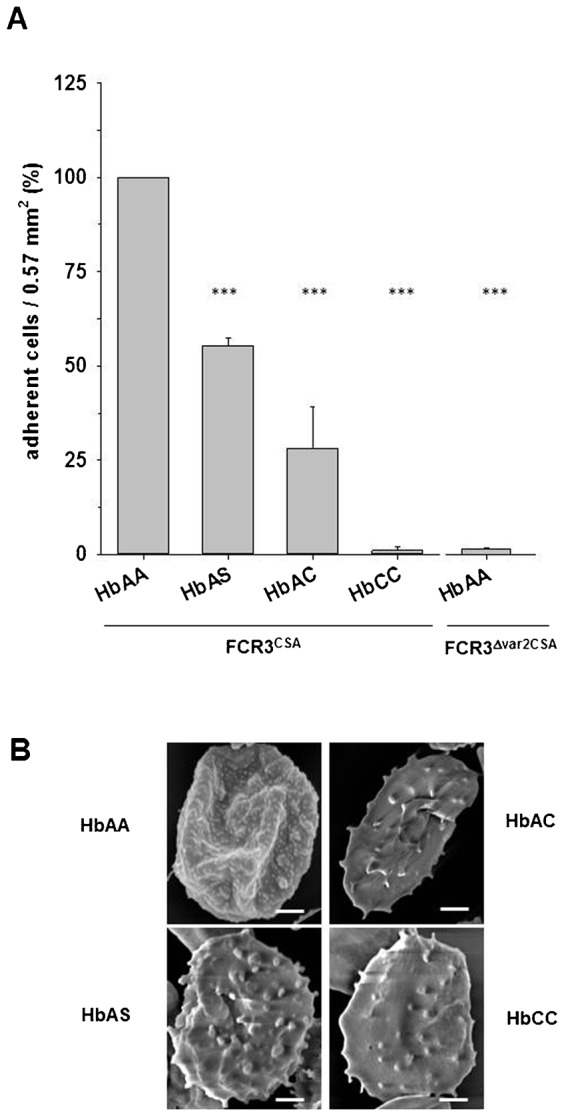
Adherence phenotype and knob morphologies exhibited by parasitized wild type and hemoglobinopathic erythrocytes.(A) The CSA-adherent P. falciparum strain FCR3CSA was cultured in wild type erythrocytes (HbAA) and in erythrocytes containing the hemoglobin variants HbAS, HbAC, and HbCC. As a negative control, HbAA was infected with a var2csa knockout strain, termed FCR3Δvar2CSA (Viebig et al., 2005), which exhibited a null CSA-binding phenotype. 5×106 cells were investigated in each experiment. The number of adherent cells per field of view (0.57 mm2) were quantified and normalized to parasitized wild-type erythrocytes (HbAA). Statistics was performed using the Kruskal-Wallis test followed by a pairwise Wilcoxon rank-sum test with Bonferroni correction (***p<0.001). Error bars represent relative standard errors of the mean. (B) Morphology of parasitized HbAA, HbAS, HbAC, and HbCC erythrocytes, as imaged by scanning electron microscopy. Scale bars represent 2 µm.